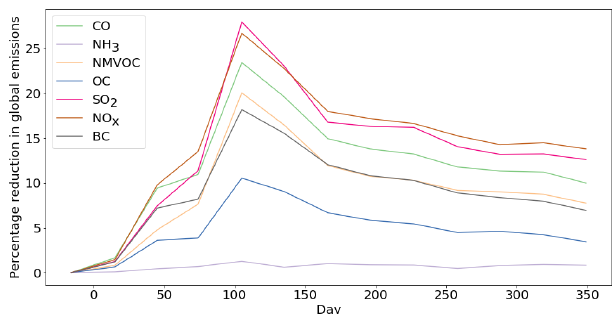
Figure 3. Monthly global emissions reduction estimates for 2020 in version 5 of the data.